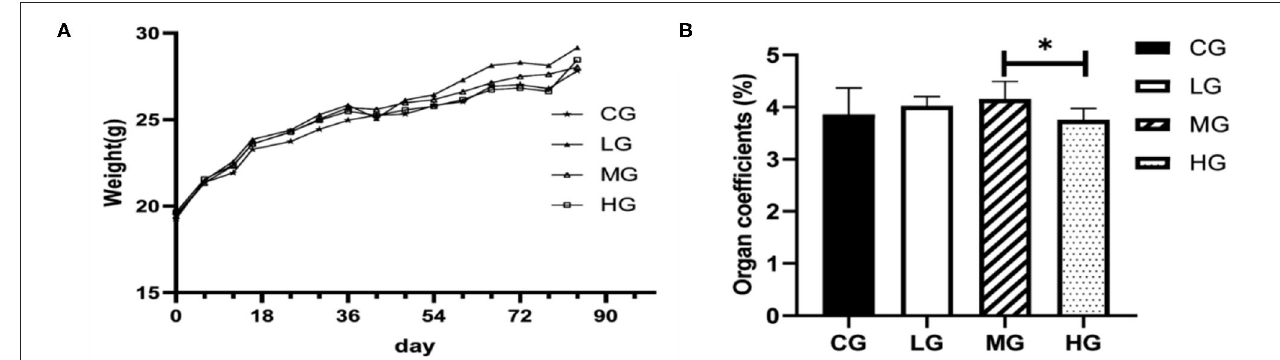
FIGURE 1 | Changes of body weights of the mice during the experiment (A) , liver coefficient (B) (* P < 0.05, n = 6).